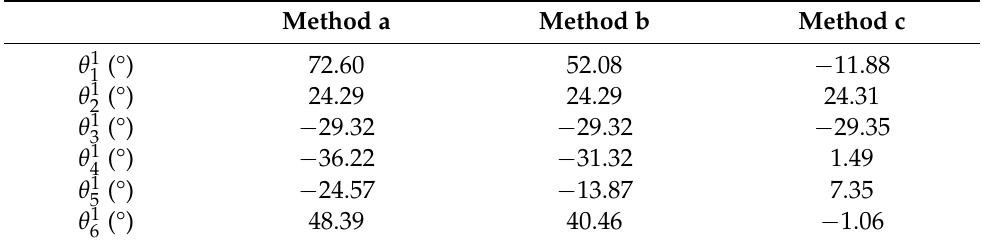
Table 6. The maximum joint angular velocity components of Arm-1 in three comparing methods.